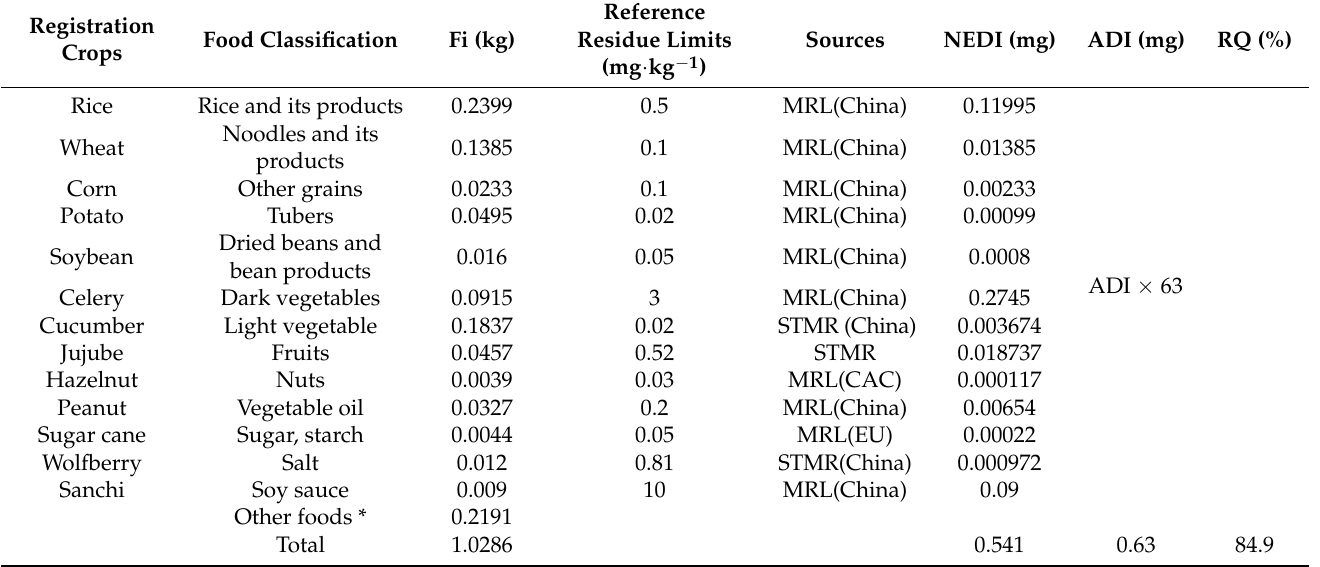
Table 5. Long-term dietary risk assessment for